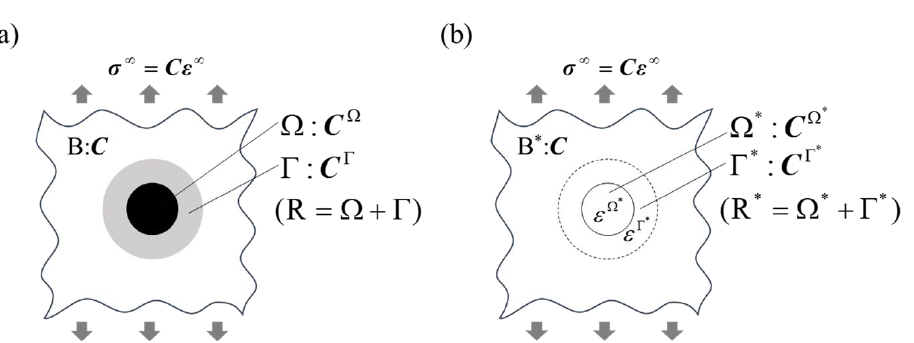
Figure 4. Modeling of PSZ and Ti oxide in an infinite medium of Ti matrix for DIM. ( a ) A double inclusion in an infinite medium; ( b ) problem equivalent to ( a ).